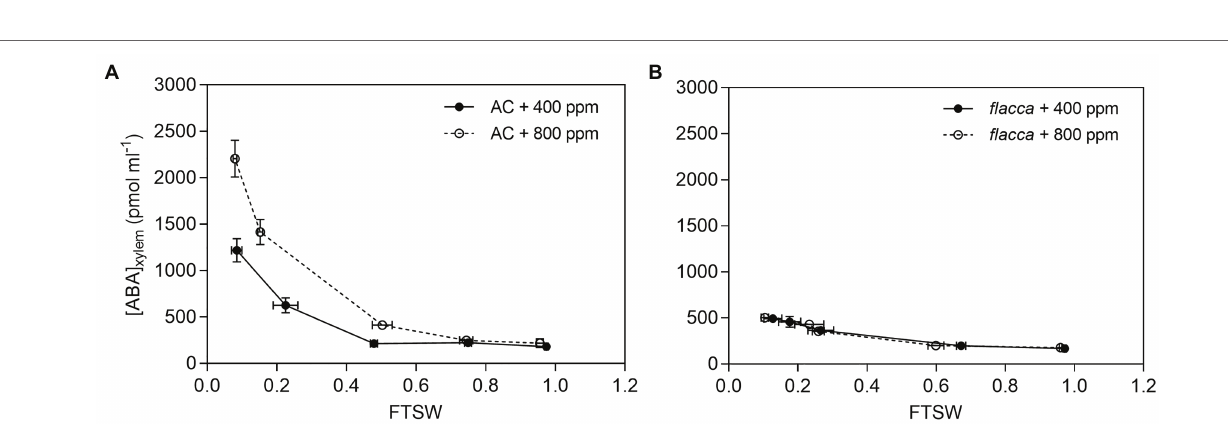
FIGURE 4 | Trends of xylem sap ABA concentrations ([ABA] xylem ) of AC (A) and flacca (B) grown under ambient (400 ppm) and elevated (800 ppm) atmospheric CO 2 concentrations during progressive soil drying. Closed circles indicate plants under 400 ppm CO 2 concentration, and open circles indicate plants under 800 ppm CO 2 concentration. Error bars indicate standard error of the means (SE; N =